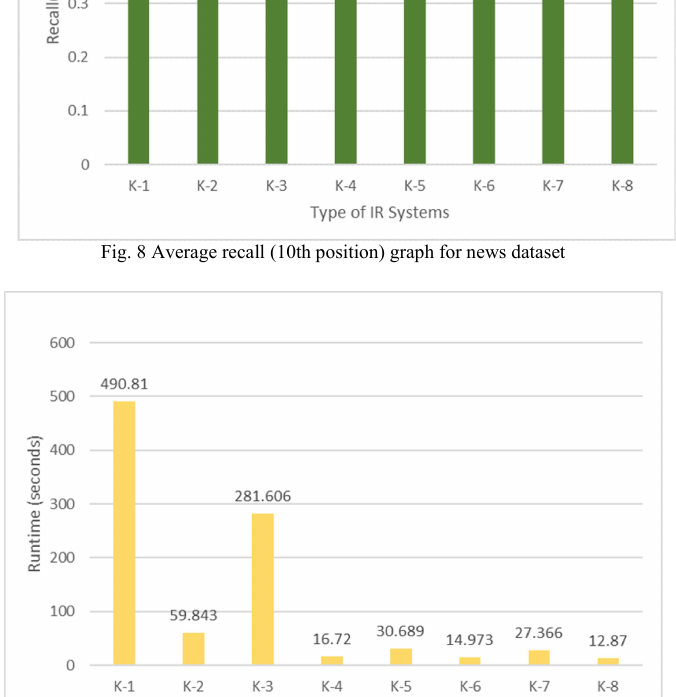
Fig. 9 Average runtime graph for abstract thesis